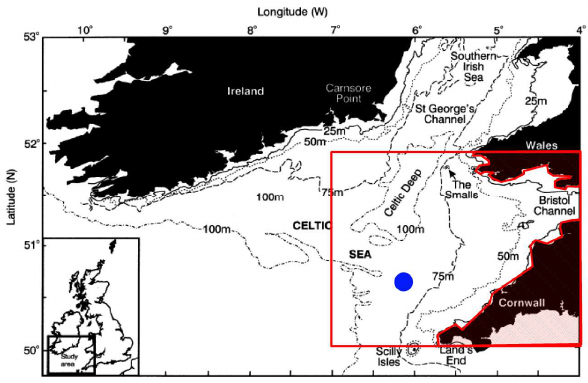
Fig. 2. Bathymetric map of the Celtic Sea showing the study area Fig.2. Bathymetric map of the Celtic Sea showing the study area (red rectangle) and 635 (red rectangle) and location of the tidal farm (blue location of the tidal farm (blue spot). 636